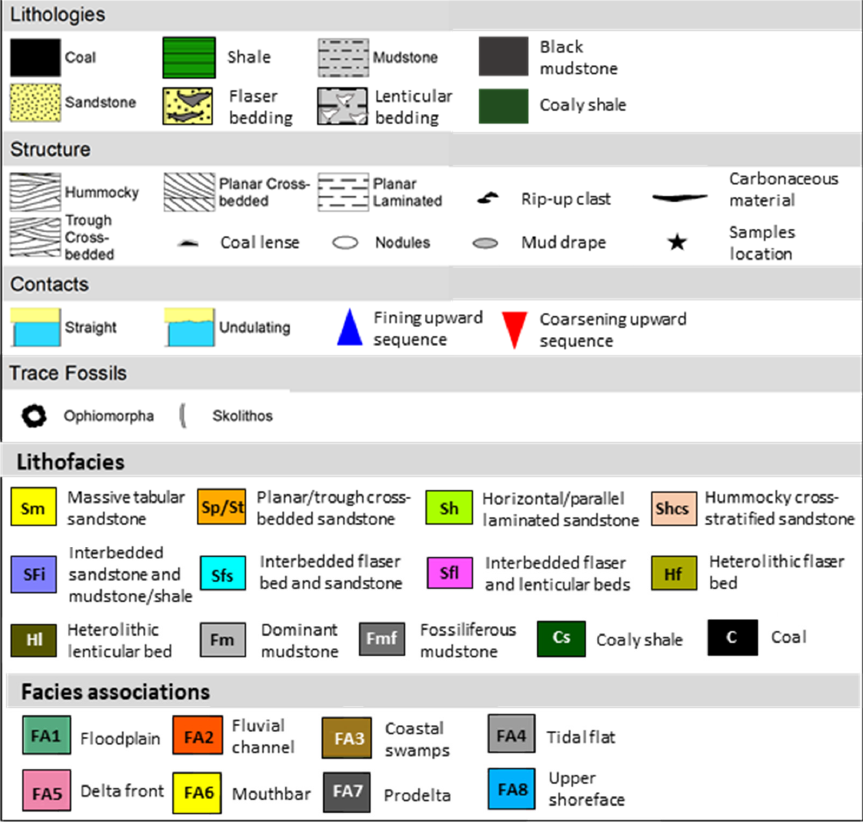
Figure 5. The symbols indicate sedimentary structures, lithofacies, and facies associations in the measured sedimentary log